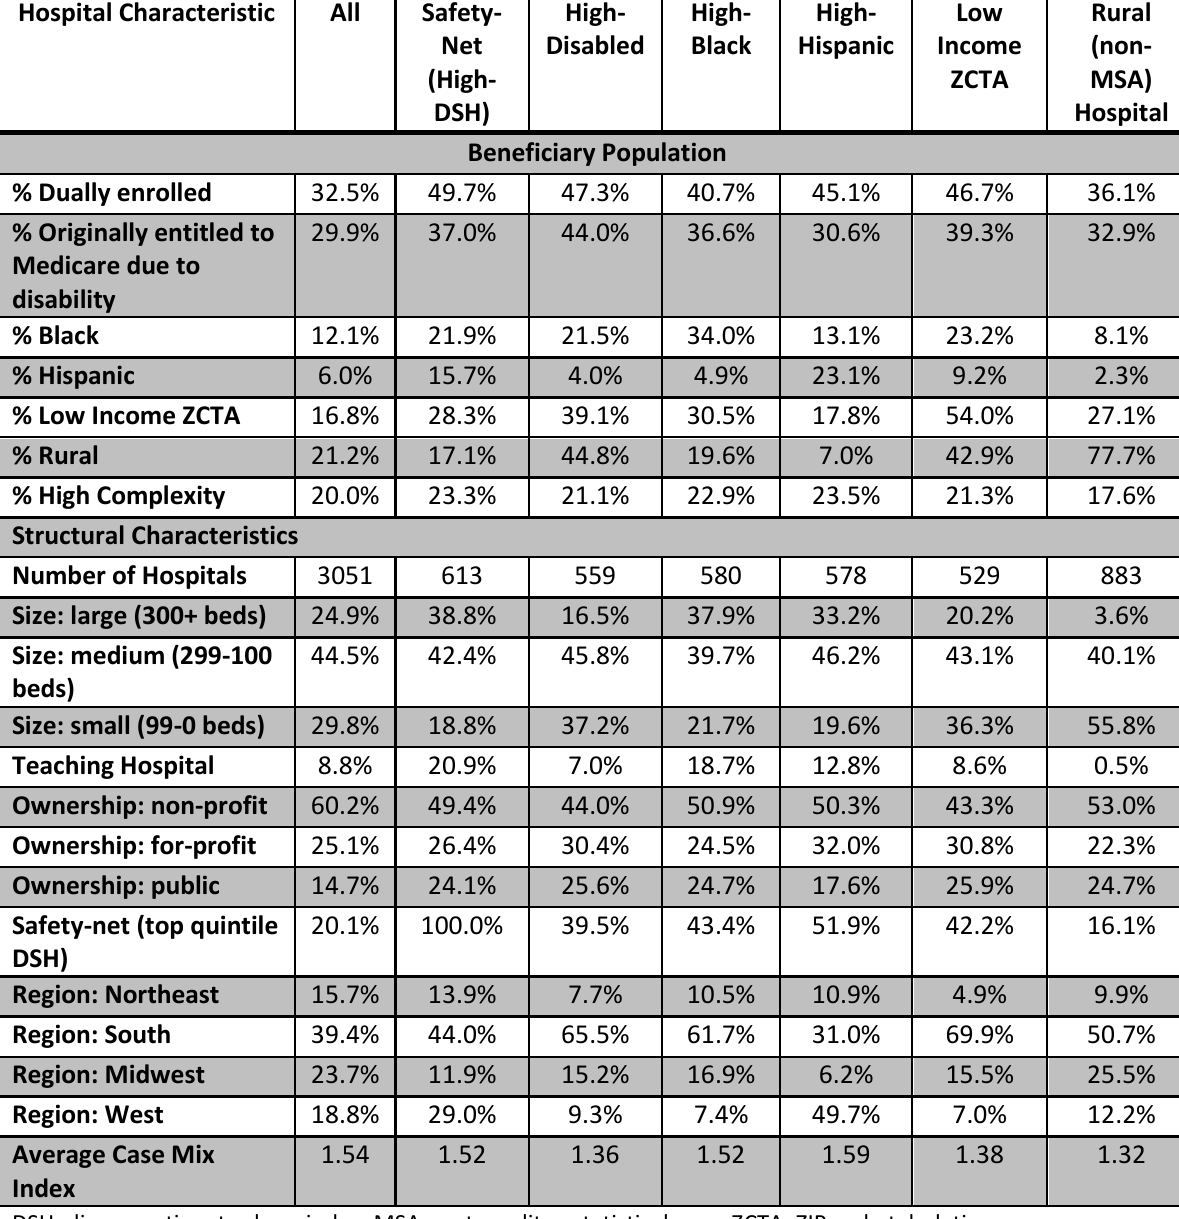
Table 7.2. Hospital Characteristics by Social Risk